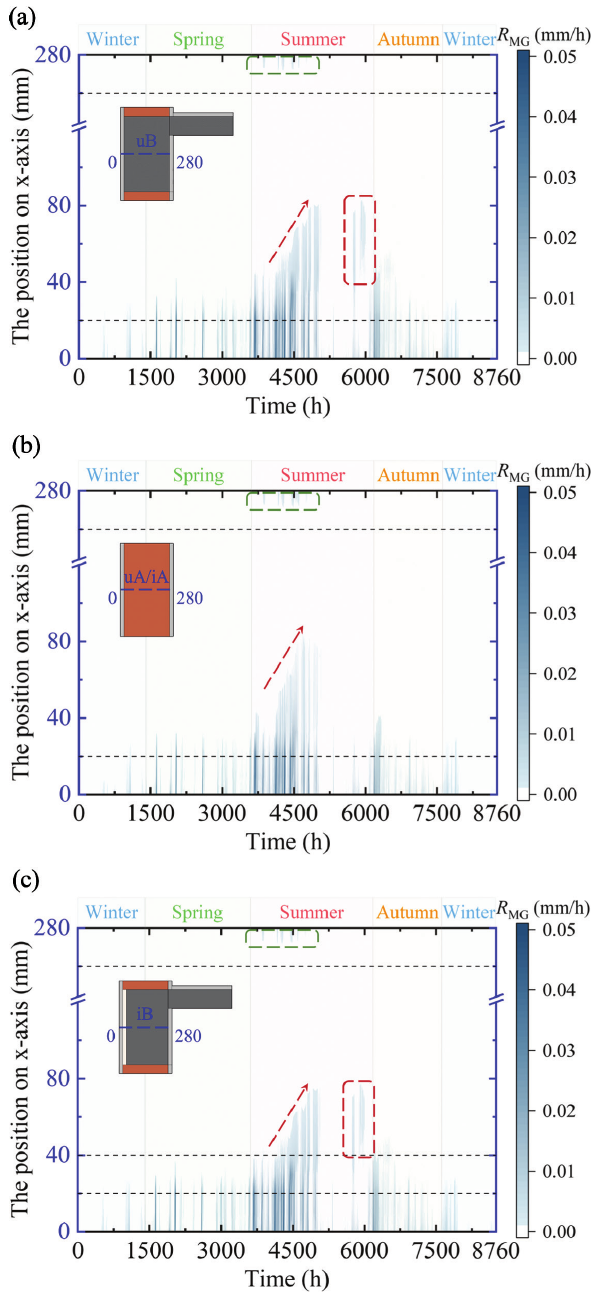
The growth rate of mycelia within different areas of building envelopes at all times of the year: (a) the uninsulated WFTB, (b) the main part of the wall, and (c) the insulated